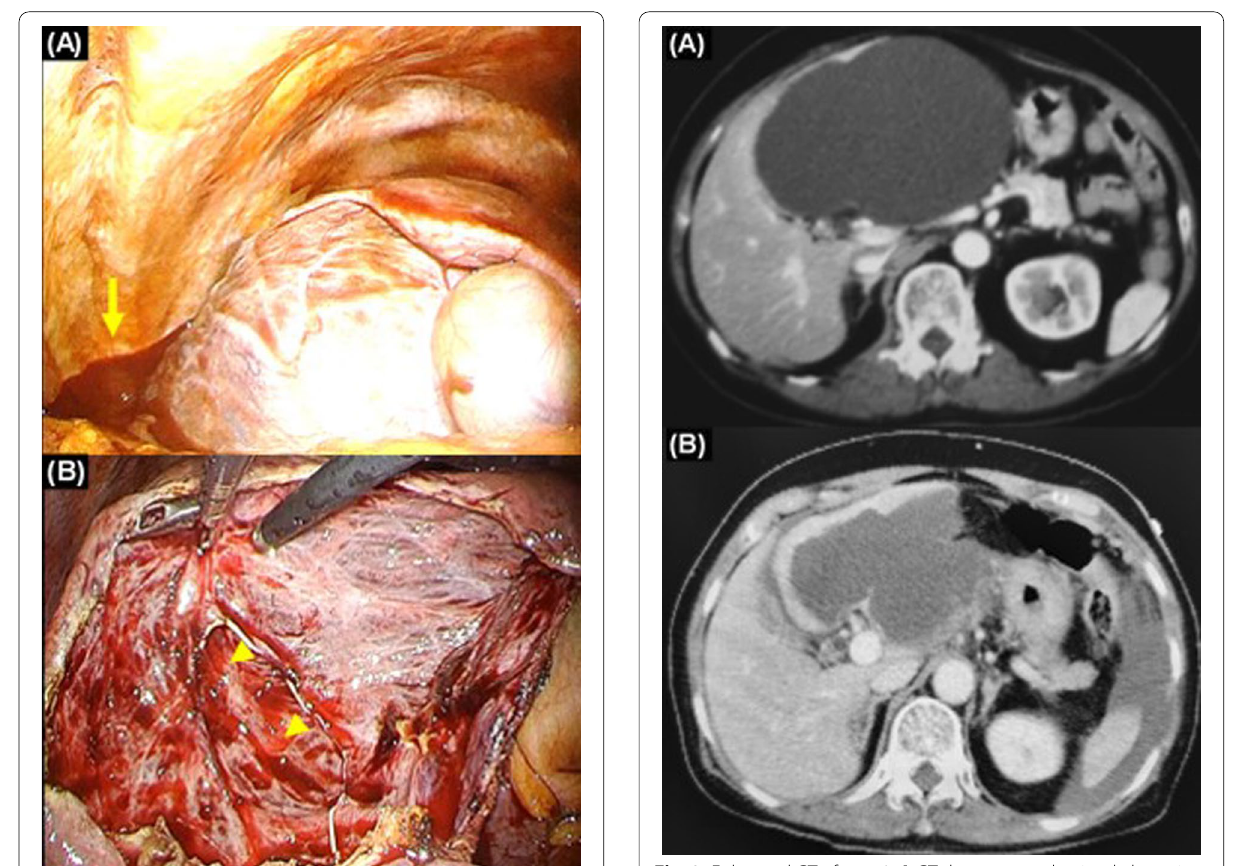
Fig. 3 Enhanced CT of case 2. A CT demonstrated a simple hepatic cyst (13 cm) in segment 4 previously. B CT showed ruptured cyst (9.9 cm) and fluid collection between the spleen and the abdominal